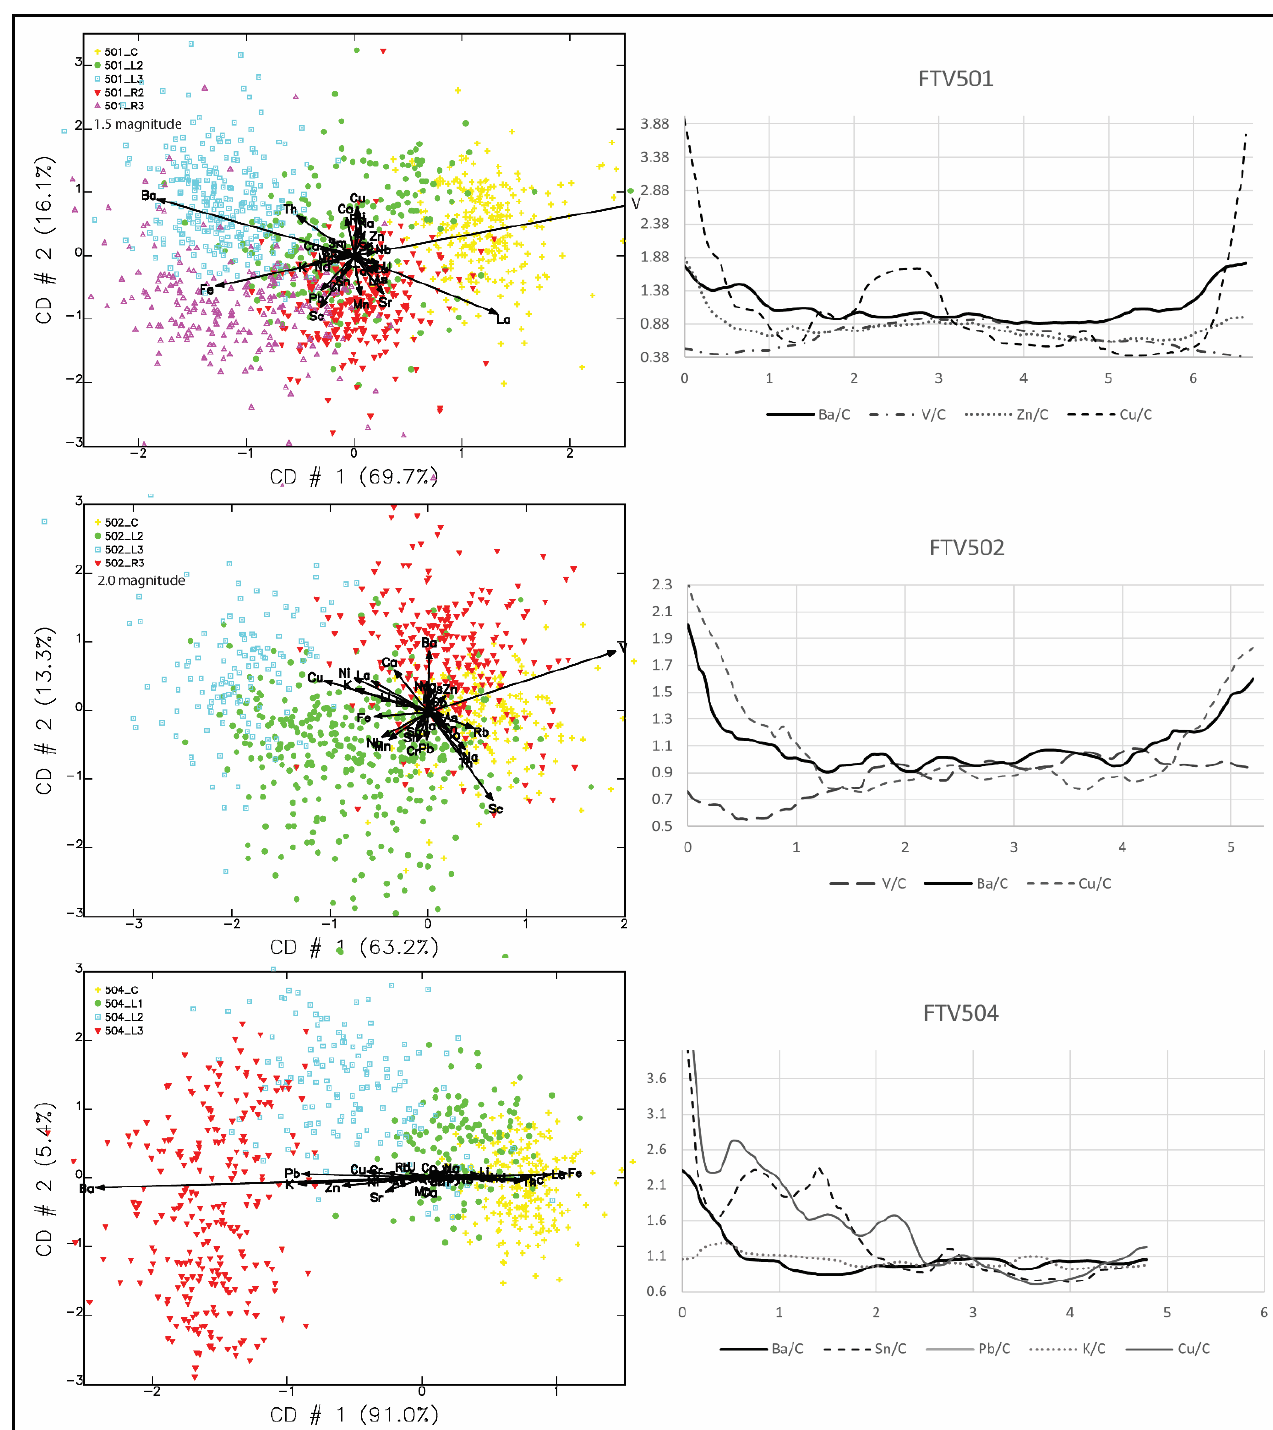
Figure 13. ( Left ) Canonical discriminant analysis of trimmed data points coded by zone (zones that do not diverge from the core not shown). ( Right ) Profiles of trimmed and smoothed data for elements that show significant zonal patterning. The x-axis is the position in the cross-section of the sherd in millimeters; the y-axis is the concentration of elements (in μg/g) expressed as a ratio to the average core concentration for the same element.